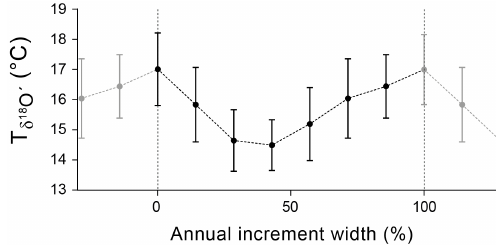
Figure 5. Average seasonal temperature changes (black dots, ± 1 σ ) based on mathematically re-sampled shell oxygen isotope values ( δ 18 O shell ’ values; see text for explanation) of 40 annual increments measured in three specimens of Glycymeris planicostalis . Note that the resultant temperature curve is not symmetric as one would ex- pect, but right skewed, indicating slower shell growth occurred dur- ing fall and winter than during the remainder of the year. In other words, more shell material was deposited during spring and summer than during fall and